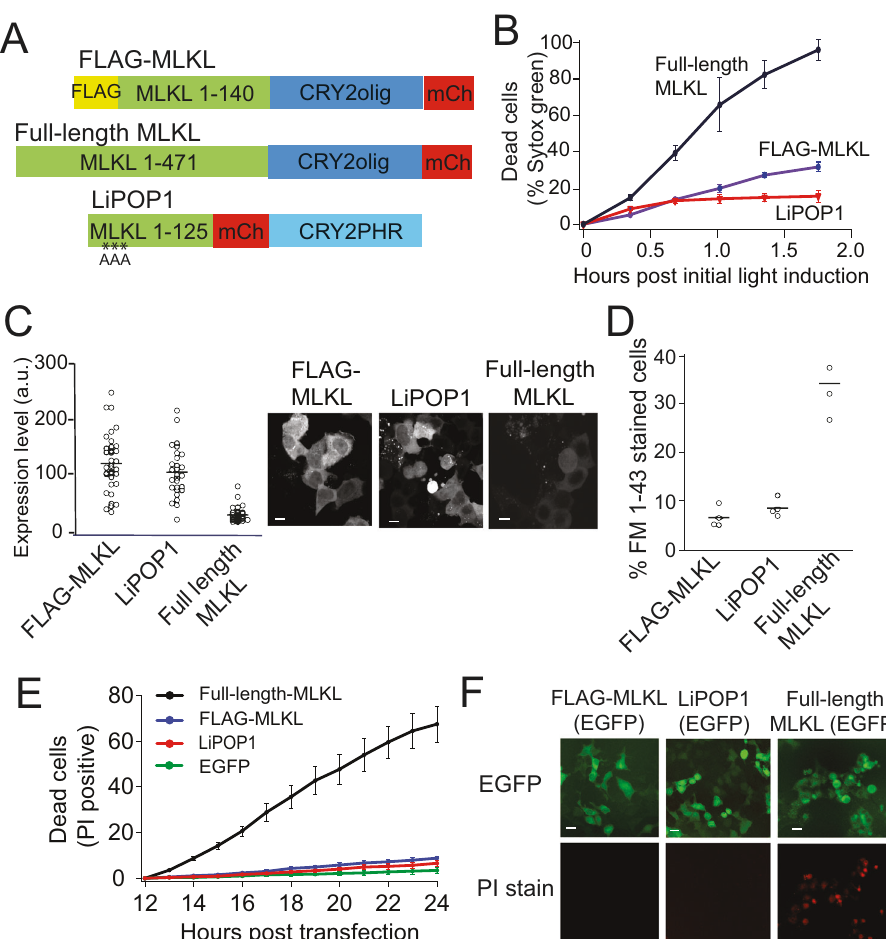
Fig. 7 Comparison of light-activated MLKL versions. A Schematic showing constructs compared in the study. B HEK293T cells expressing indicated mCherry-tagged MLKL constructs were quanti fi ed for cell death (Sytox green positive staining) in response to light (488 nm light every 20 min for 100 min). Graph shows mean ± s.e.m, n = 3 independent experiments. C Quanti fi cation of mCherry fl uorescence within cells expressing indicated MLKL constructs described in ( A ), with representative images at right. Scale bars, 10 µm. D Quanti fi cation of FM1 – 43 staining in cells expressing mCherry-tagged versions of MLKL and incubated in the dark. Data represents mean ± s.e.m. for three independent experiments. E Quanti fi cation of background cell death in the dark (absence of blue light). EGFP-tagged versions of indicated MLKL versions (or EGFP as a control) were quanti fi ed for cell death (positive PI-staining) over time in the dark. Data are expressed as a percent of cells with PI-positive stain, out of total MLKL expressing cells, and represents mean ± s.e.m., n = 3. F Representative images of